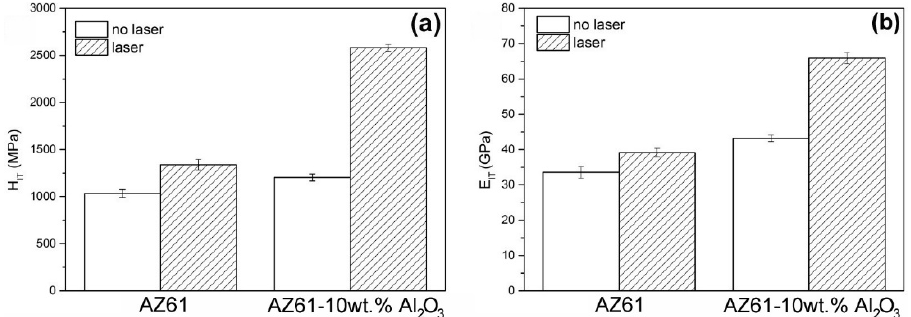
Figure 5. Nanoindentation characteristics of the investigated materials: ( a ) indentation nanohardness and ( b ) indentation modulus of elasticity.